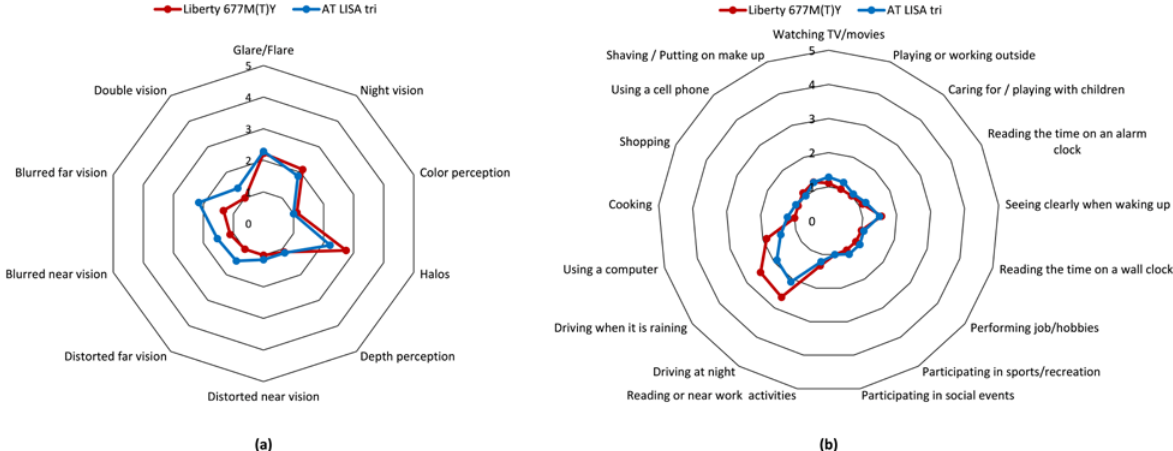
Figure 5. Mean responses for ( a ) dysphotopsia and ( b ) visual function assessment using a modified visual function questionnaire completed at 12 months postoperatively. 1 = No difficulties; 2 = minor difficulties; 3 = moderate difficulties; 4 = major difficulties; 5 = cannot accomplish task. No significant differences between the two lenses could be revealed.